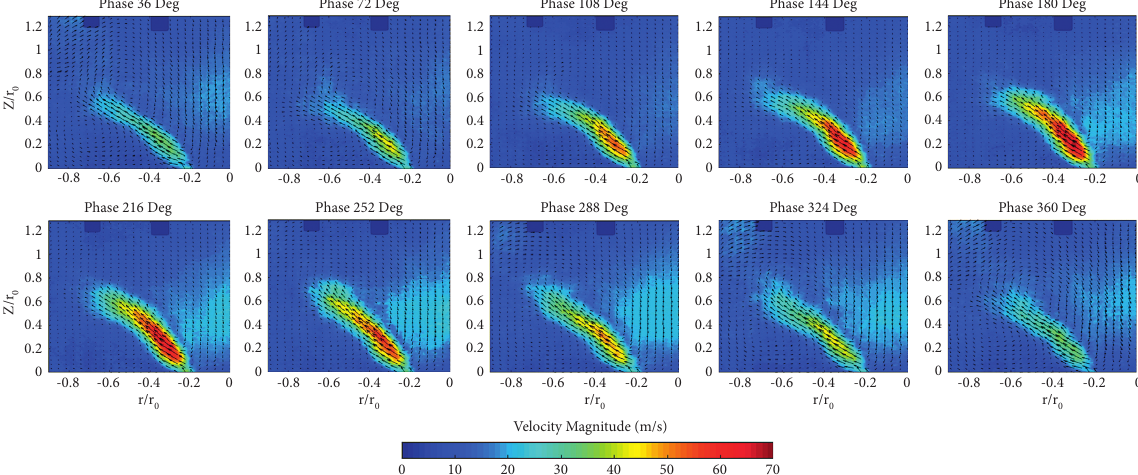
Figure 10: Phase averaged velocity contours for the no PIM case. The scale is velocity magnitude in m/s.